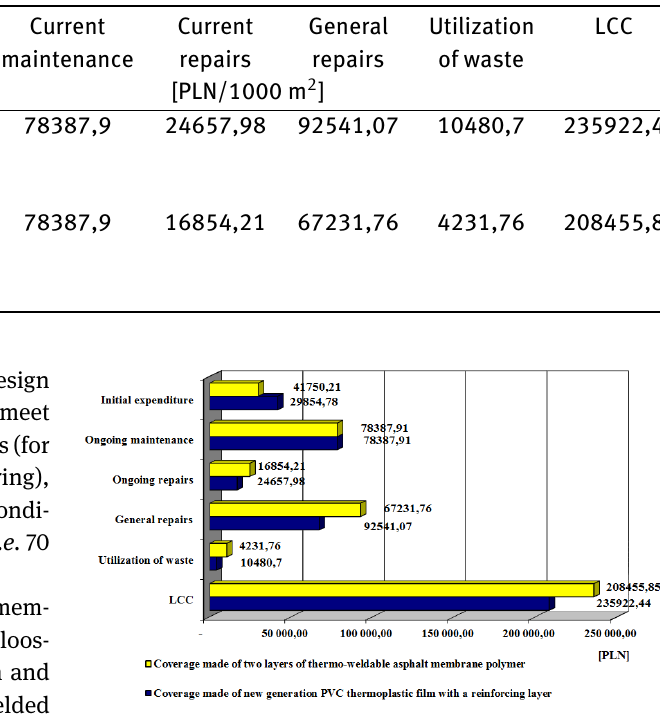
Figure 2: LCC analysis for two variants of roofing (source: own